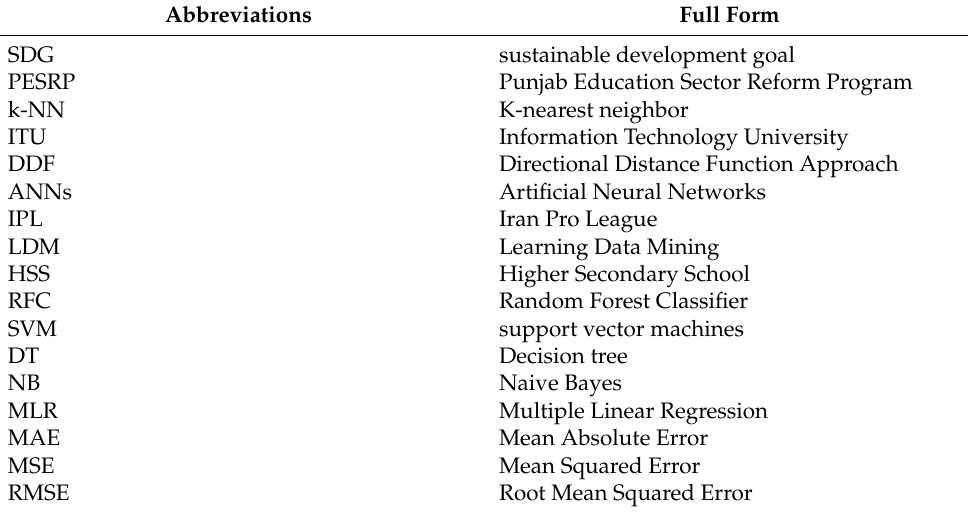
Table 1. List of